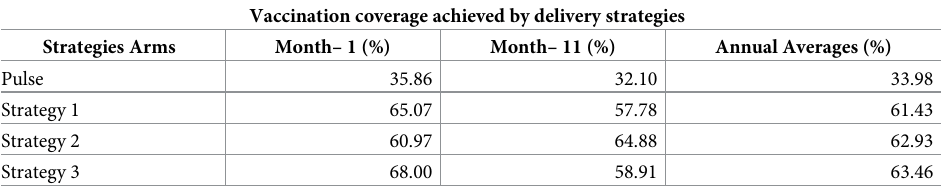
Table 5. Vaccination coverage achieved by the delivery strategies at month 1 and